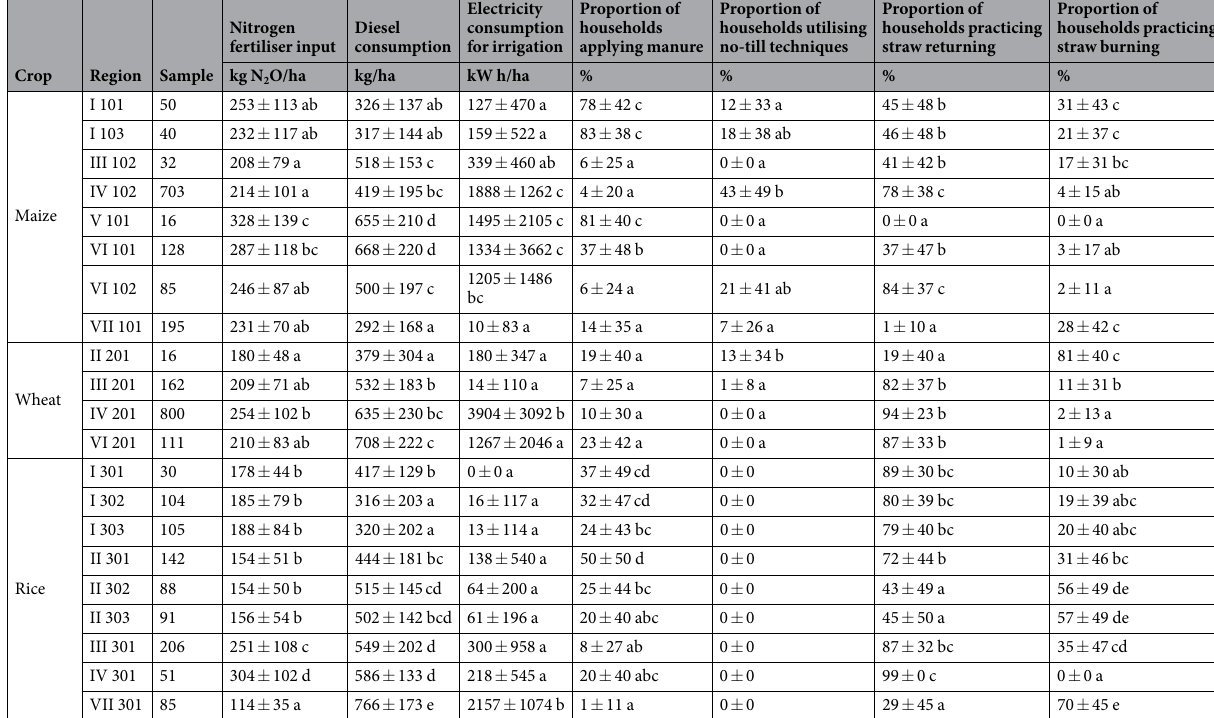
Table 1. Differences in the production techniques for three main crops across various primary production areas in China. Note: Mean ± SD. Different letters indicate significant differences among different regions of the same crop at P < 0.05 (ANOVA). Crop codes: 101 = spring maize; 102 = summer maize; 103 = autumn maize; 201 = winter wheat; 301 = single-crop rice; 302 = double-cropped early rice; 303 = double-cropped late rice. Area codes: I = triple-cropping area in South China, II = double-cropping rice area in South China, III = lower basin of the Yangtze River (paddy–upland rotation area), IV = North China Plain, V = irrigated area in Northwest China; VI = arid area in Northwest China, VII = single crop area in Northeast